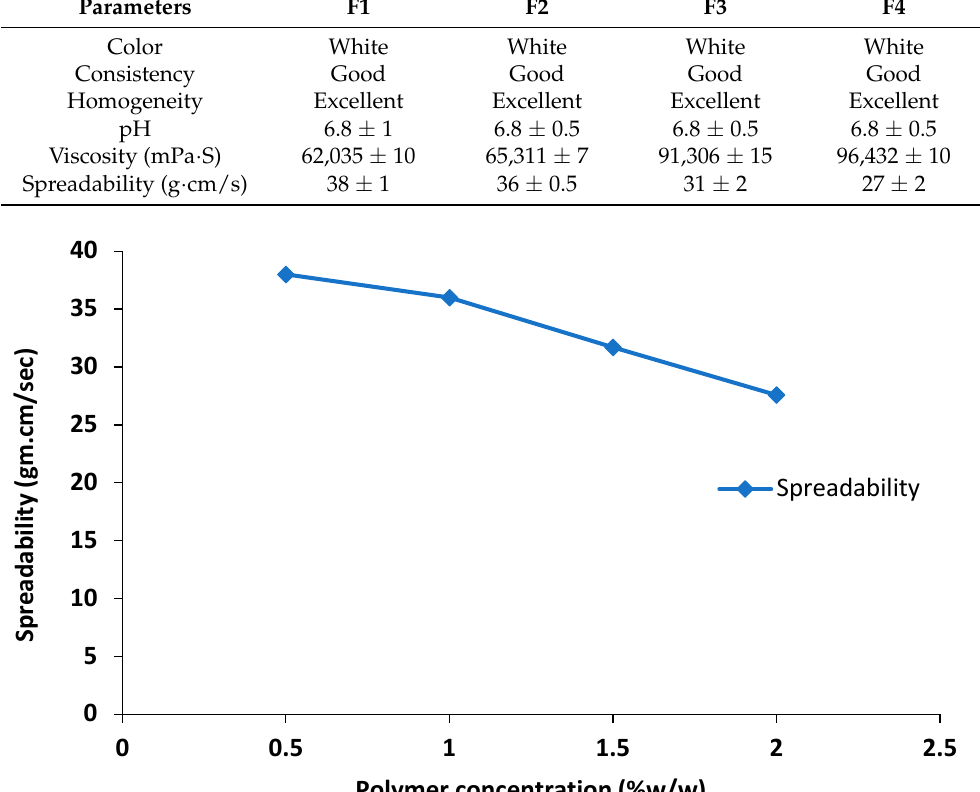
Figure 3. Effect of polymer concentration on viscosity of nanoemulgel. 2.7. FTIR FTIR analysis is utilized to ascertain the drug-excipient compatibility in nanoemulgel formulations. The characteristic peaks of essential oils and other excipients, both alone and in the optimized nanoemulgel formulation, were found to match the previously re- ported functional groups of these constituents. For instance, in the FTIR spectrum of olive oil, peaks at 2923 cm − 1 and 2845 cm − 1 correspond to OH and fatty acid stretching, while a peak at 1744 cm − 1 represents the ester C=O group (Figure 4). In clove oil, a peak at 3452 cm − 1 represents OH stretching, and peaks at 1512 cm − 1 , 1425 cm − 1 , and 1266 cm − 1 corre- spond to the aromatic C=C and phenolic group. In cinnamon oil, a peak at 3452 cm − 1 represents OH stretching, a peak at 1670 cm − 1 corresponds to the C=O group, a peak at 1624 cm − 1 represents the C=C group, a peak at 745 cm − 1 corresponds to the aromatic C-H group, and a peak at 970 cm − 1 indicates C-H bending. In the FTIR spectrum of Carbopol